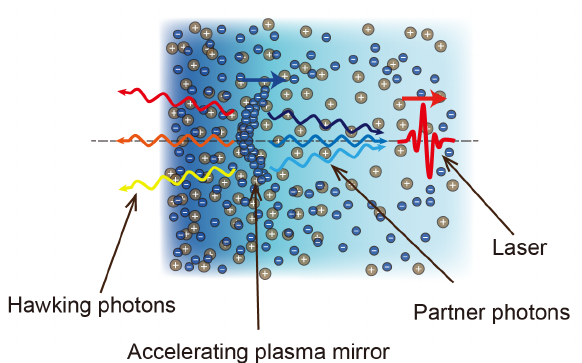
Figure 3. Schematic drawing of the concept of accelerating plasma mirror driven by an intense laser that traverses a plasma with a decreasing density. Due to the variation of the laser intensity in the transverse dimension, which is typically in Gaussian distribution, the flying plasma mirror induced by the laser is concave in the forward